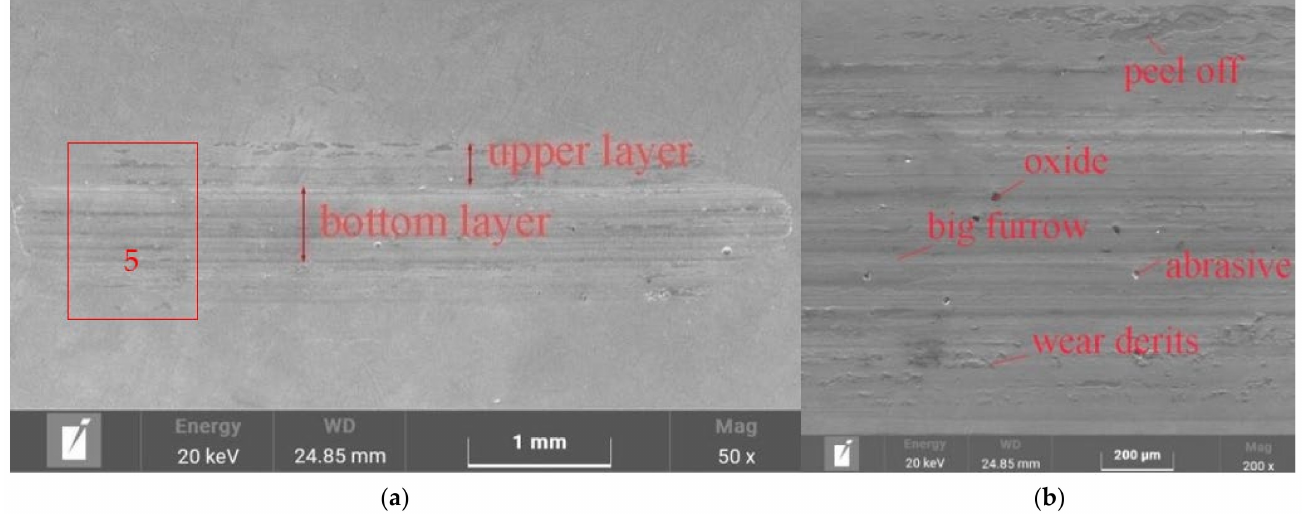
Figure 32. Surface morphology under a force of 80 N and friction speed is 500 mm/min after laser hardening at a scanning speed of 800 mm/min. ( a ) 50 × magnification and ( b ) area 5 at 200 ×